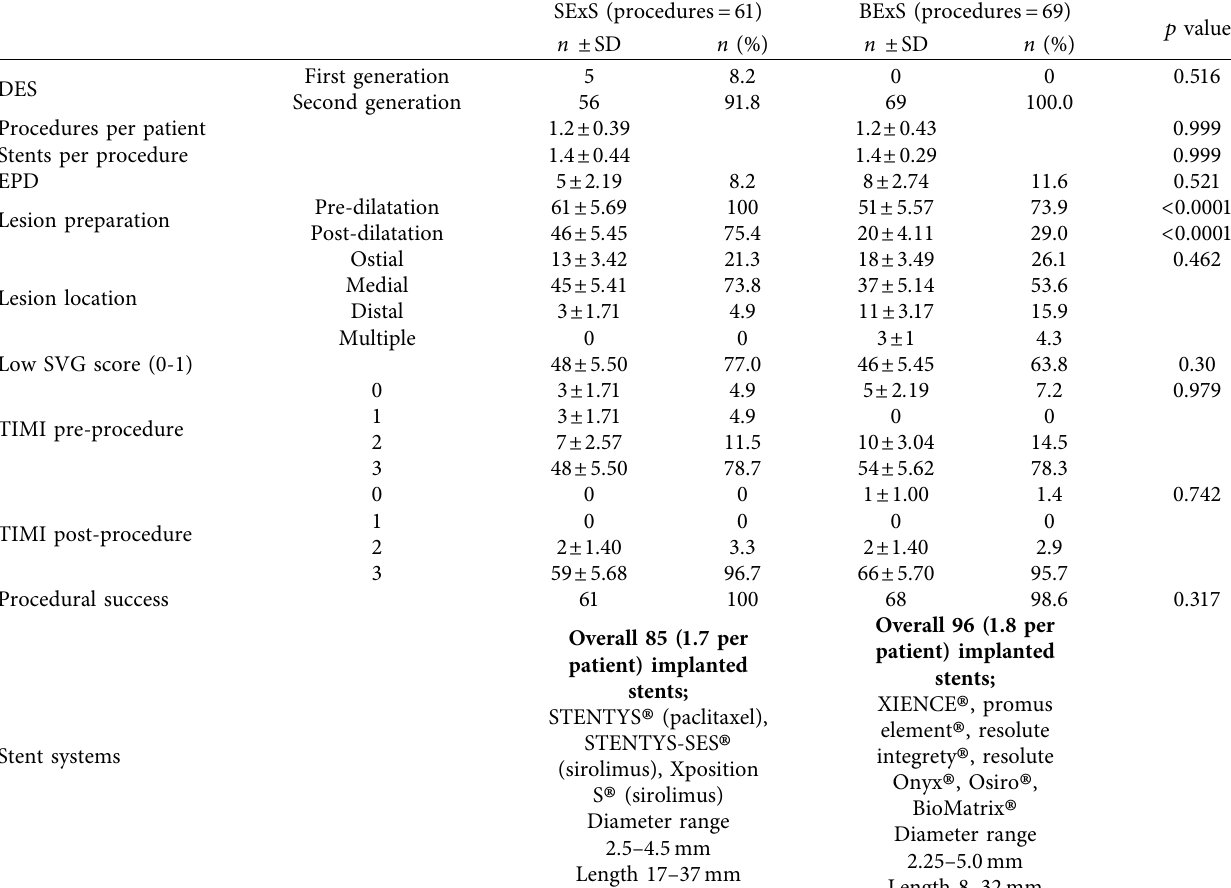
Table 2: Procedural characteristics.